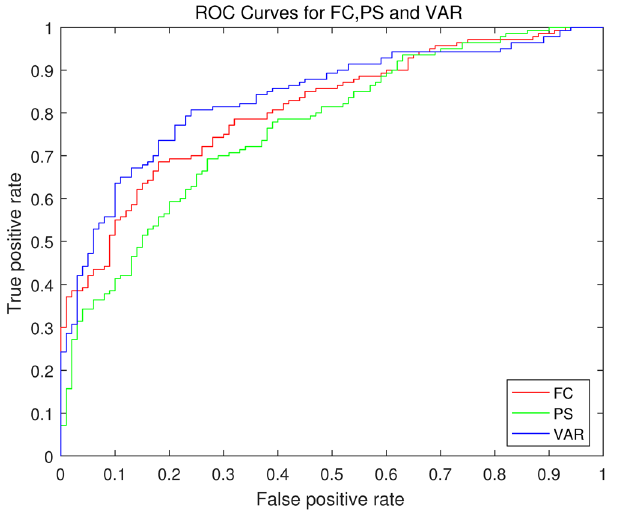
Figure 1. ROC curves based on LOOCV. The red curve denotes ROC based on inter-ICN functional connectivity (FC). The green curve denotes ROC based on inter-ICN phase synchrony (PS). The blue curve denotes ROC based on inter-ICN variability